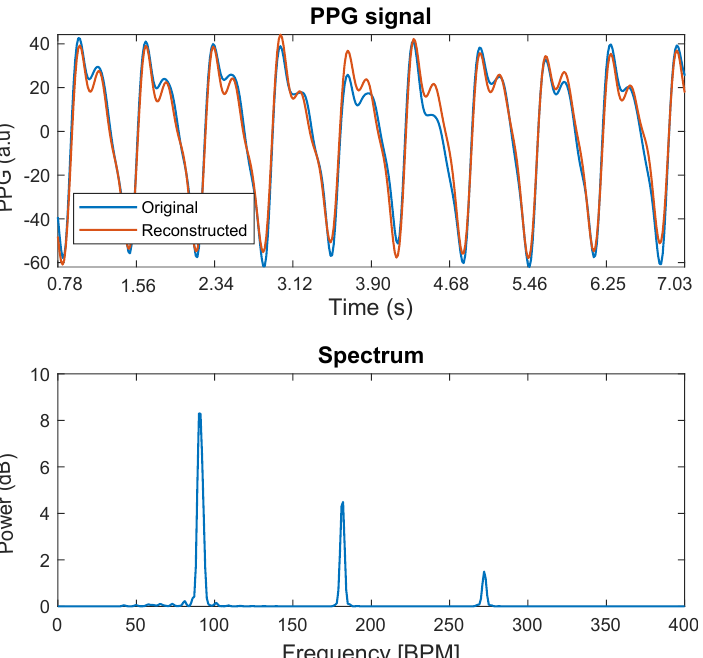
Figure 2. Example of a PPG signal reconstruction (and the spectrum of the reconstructed signal) keeping nothing but its fundamental frequency, second harmonic, and third